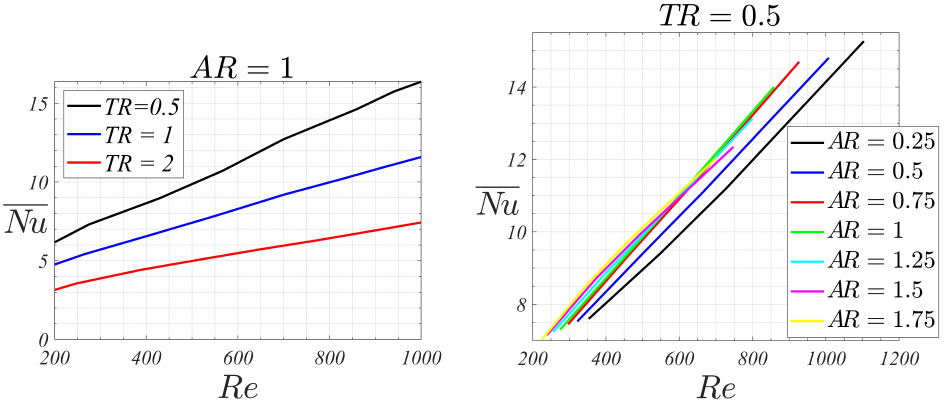
Figure 4. Nu vs. Re . ( Left ) for different tip clearance ratios TR (with AR = 1). ( Right ) for different aspect ratios AR (with TR =